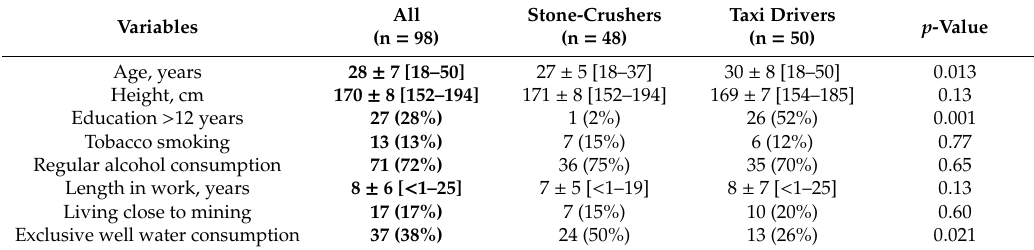
Table 1. Characteristics of artisanal stone-crushers and taxi drivers in